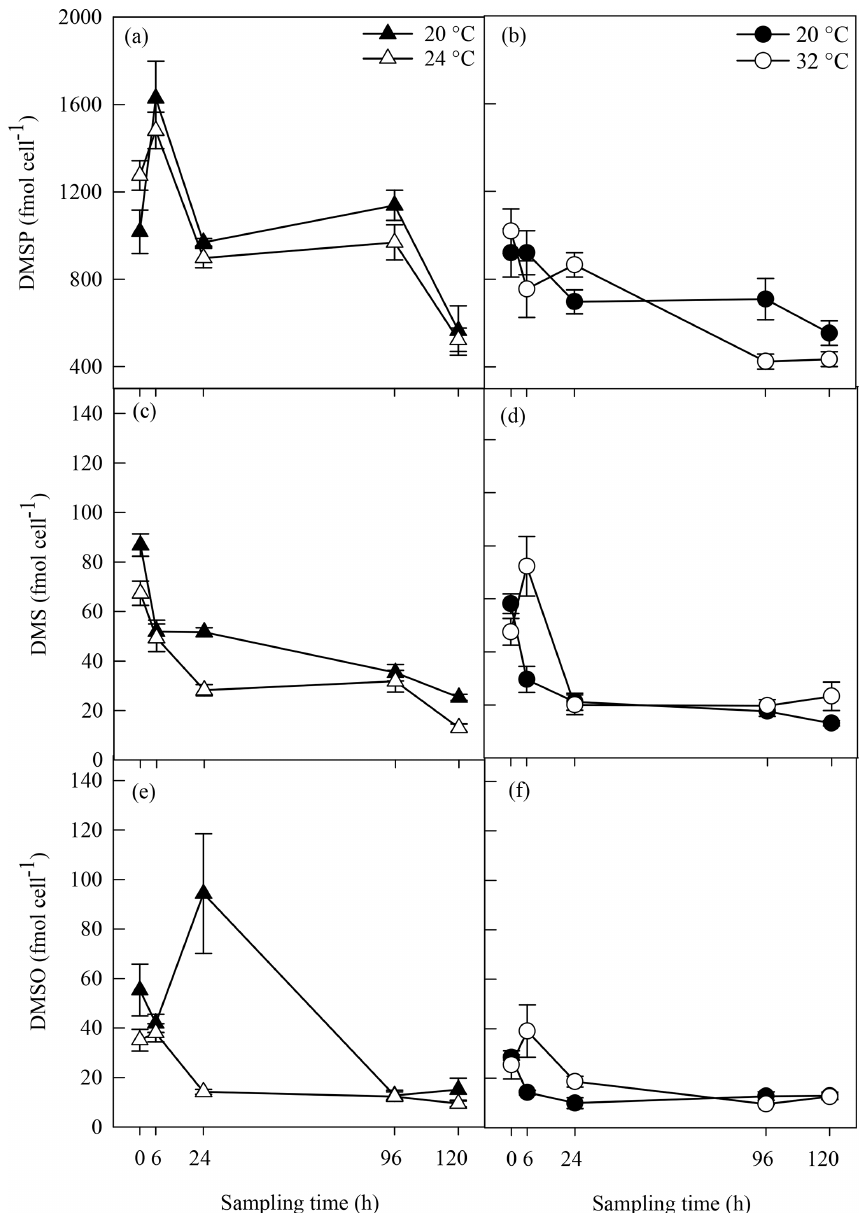
Figure 4. DMSP (a, b) , DMS (c, d) and DMSO (e, f) concentrations in A. minutum cultures in experiment 1 (20 and 24 ◦ C) (a, c, e) and experiment 2 (20 and 32 ◦ C) (b, d, f) ; average ± SE, n = 4. Variability in between the two 20 ◦ C controls is probably a consequence of experiments 1 and 2 being conducted at different times (April and June), whereby changes in the physiological state of the culture at each time led to different dimethylated sulfur